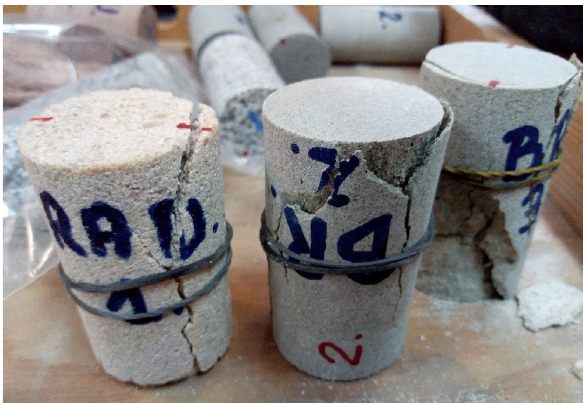
Figure 6: Cracked samples after uniaxial compression